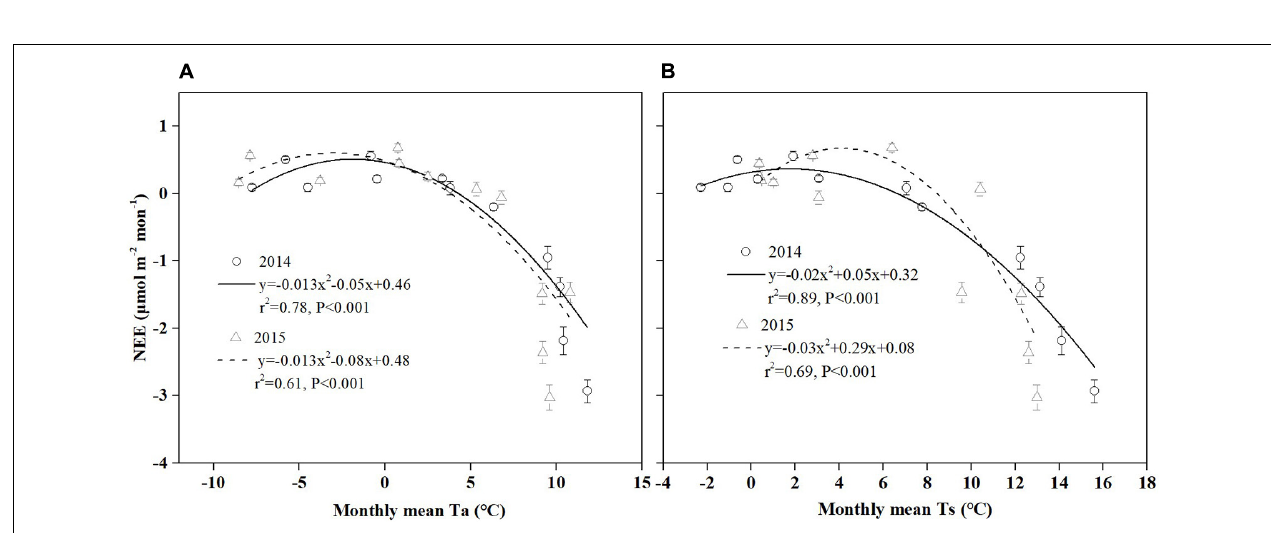
FIGURE 9 | The monthly relationship between NEE and temperature [ (A) Ta, (B) Ts] during 2014 and 2015 in the Hongyuan peatland ecosystem. Error bars in all plots denote the standard errors.